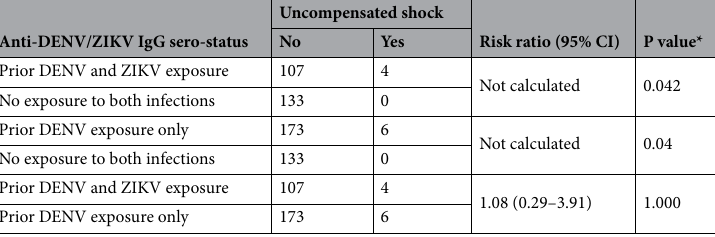
Table 3. Association between previous DENV / ZIKV exposure and uncompensated shock during the current DENV infection. *Calculated as two-tailed p value with Fisher’s exact test.